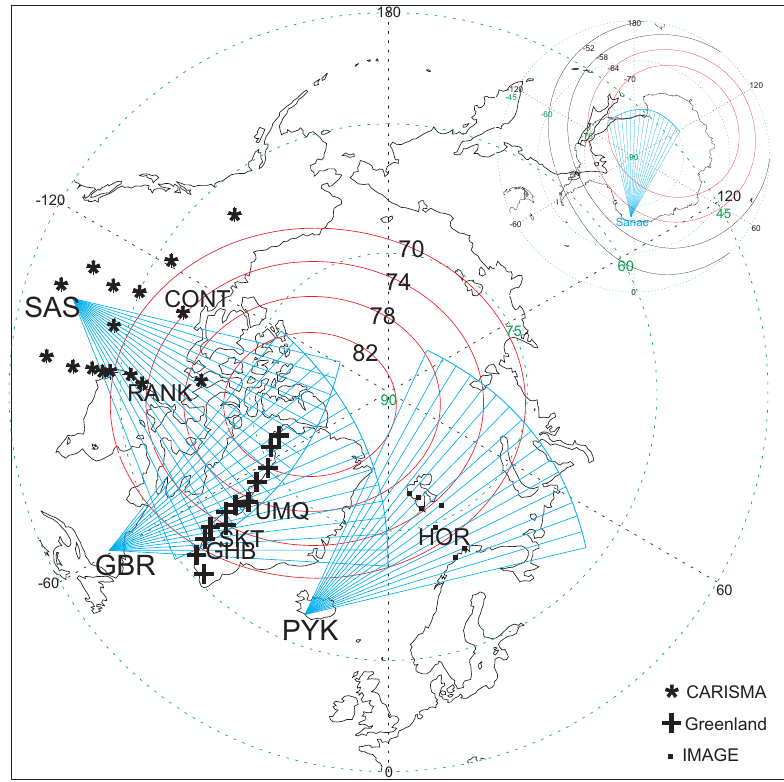
Figure 1. Fields of view of the SuperDARN radars at Saskatoon (SAS), Goose Bay (GBR) and Þykkvibær (PYK) and at Sanae (SAN) plotted (inset plot) in geographic coordinates. The solid lines are AACGM magnetic latitude for event 1 (71–73 ◦ ), event 2 (74–78 ◦ ) and event 3 (78–82 ◦